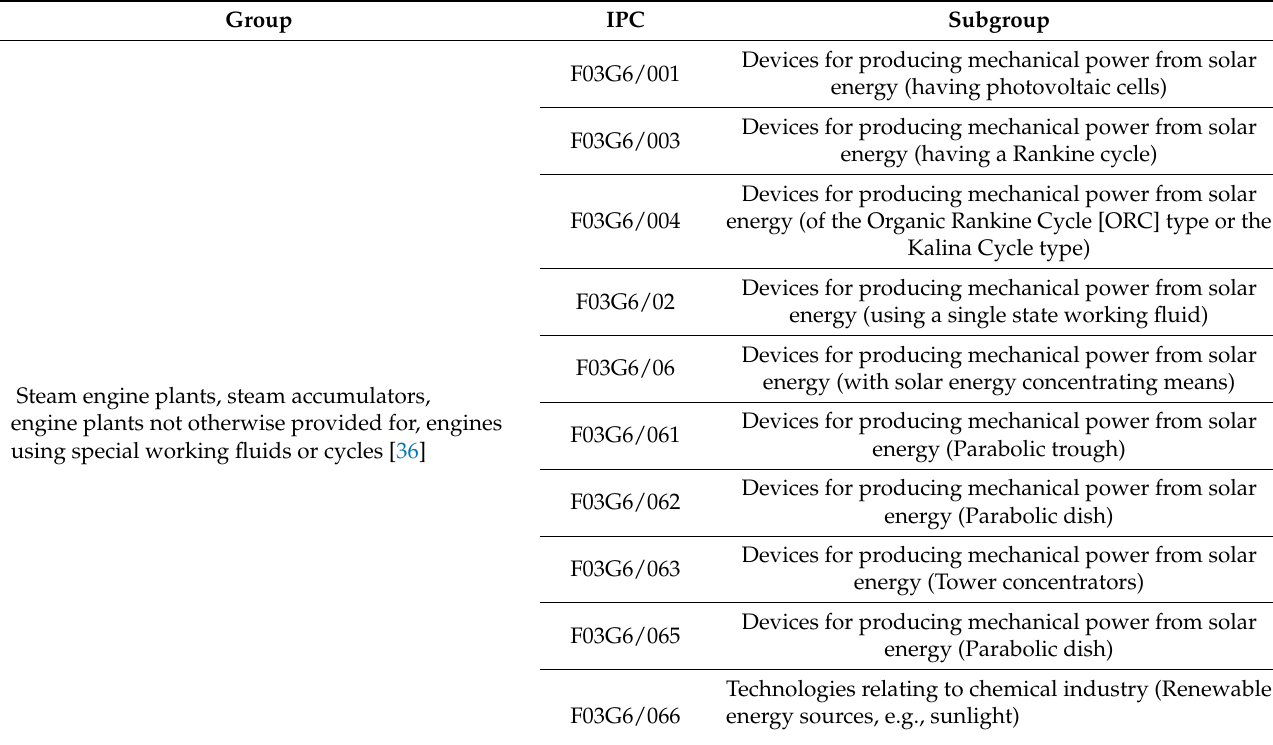
Table 3. IPC codes not indexed in the initial